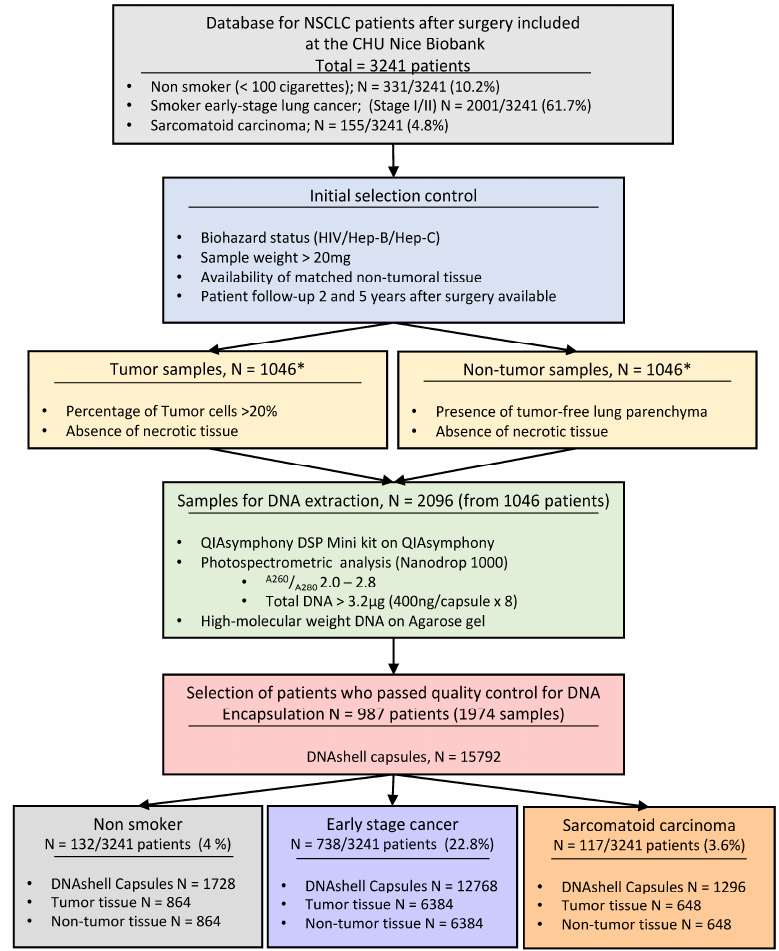
Figure 1. The different steps leading from the selection of patients and frozen tissue samples to DNA quality and quantity controls to DNA encapsulation. NSCLC = Non-Small Cell Lung Carcinoma.